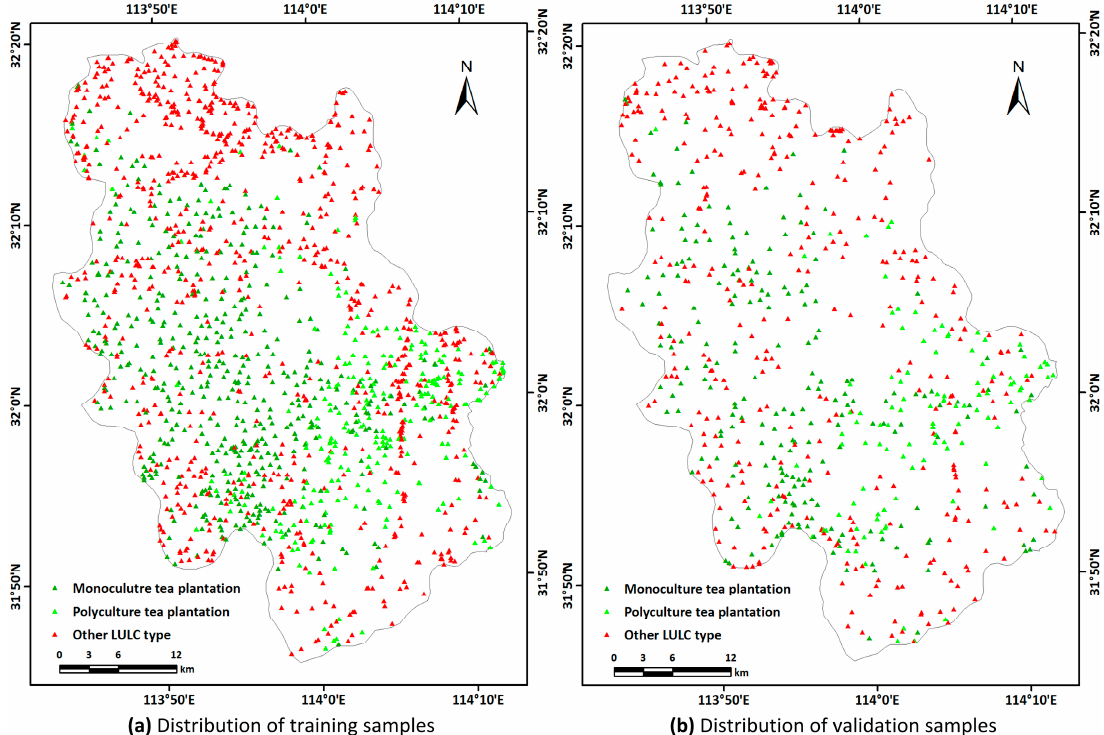
Figure 4. Distribution of samples in the study area: ( a ) 20,565 training sample pixels, of which 5654 are tea plantations; ( b ) 8756 validation sample pixels, of which 2449 are tea plantations.